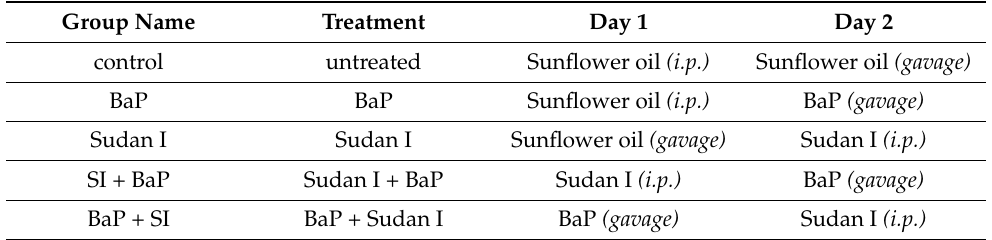
Table 3. Scheme of substance application to Wistar rats and application route. Sunflower oil was used as a vehicle. Dosage of the compounds: 150 mg/kg bw BaP or 50 mg/kg bw Sudan